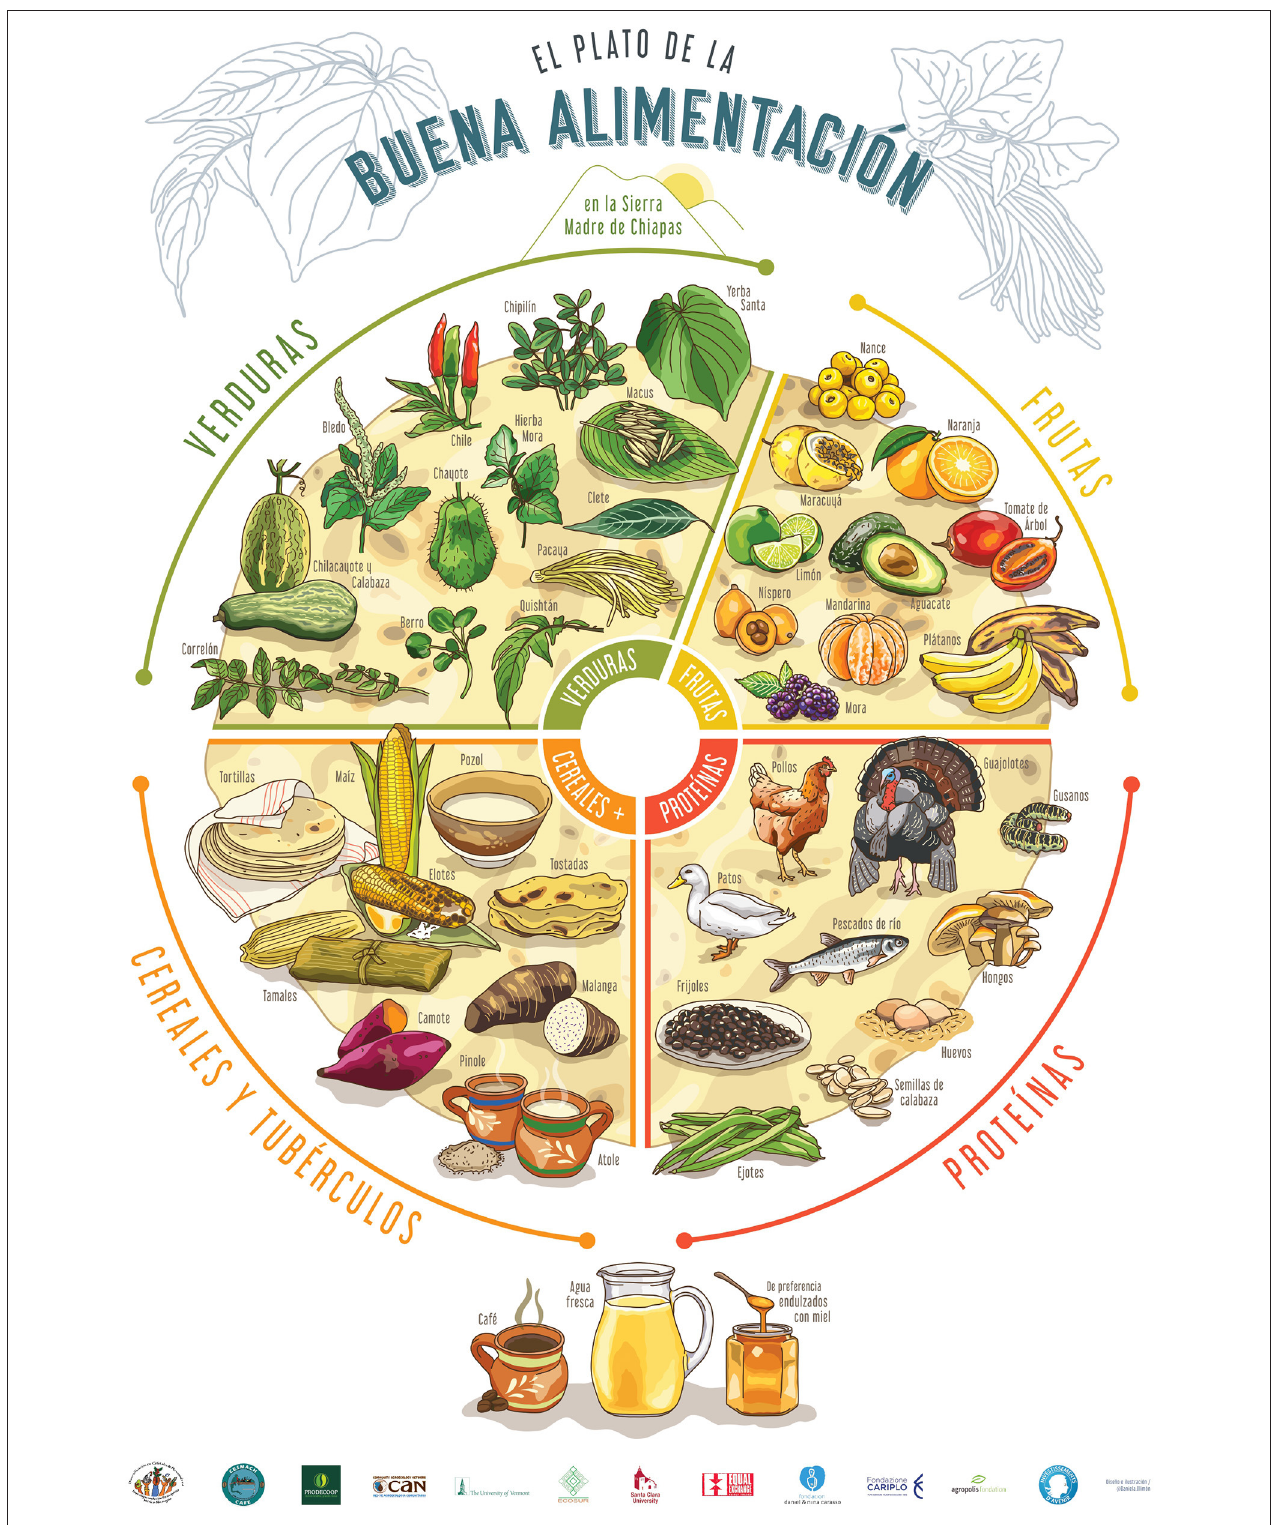
FIGURE 4 | The Chiapas Highlands Nourishment Plate education tool that highlights the most common local food resources reported by CESMACH households. Created by Daniela Gallardo Olimón.